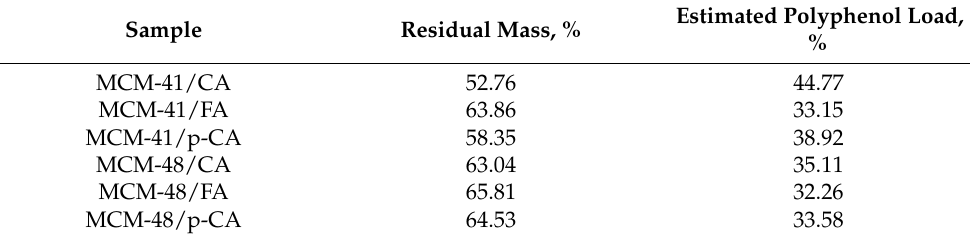
Table 4. Estimated polyphenol quantities loaded on MCM-41 and